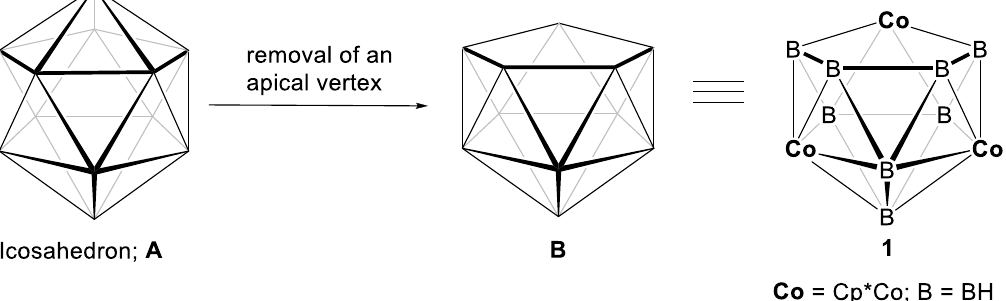
Figure 2. Schematic representation of stepwise generation of the cluster framework of 1 ( B ) from an icosahedron ( A ). Density functional theory (DFT) calculations were carried out at the B3LYP/LANL2DZ level of theory (see computational details in Section 3) on model compound 1 (cid:48) (Cp analogue of 1 ) to analyse the electronic structure and nature of bonding in the electron deficient molecule 1 . Optimized bond distances in 1 (cid:48) are in accordance with those experimentally measured for the solid-state structure of 1 (Table S1). The molecular orbital (MO) analysis of 1 (cid:48) (Table S2) shows a large energy gap of 2.79 eV between the highest occupied